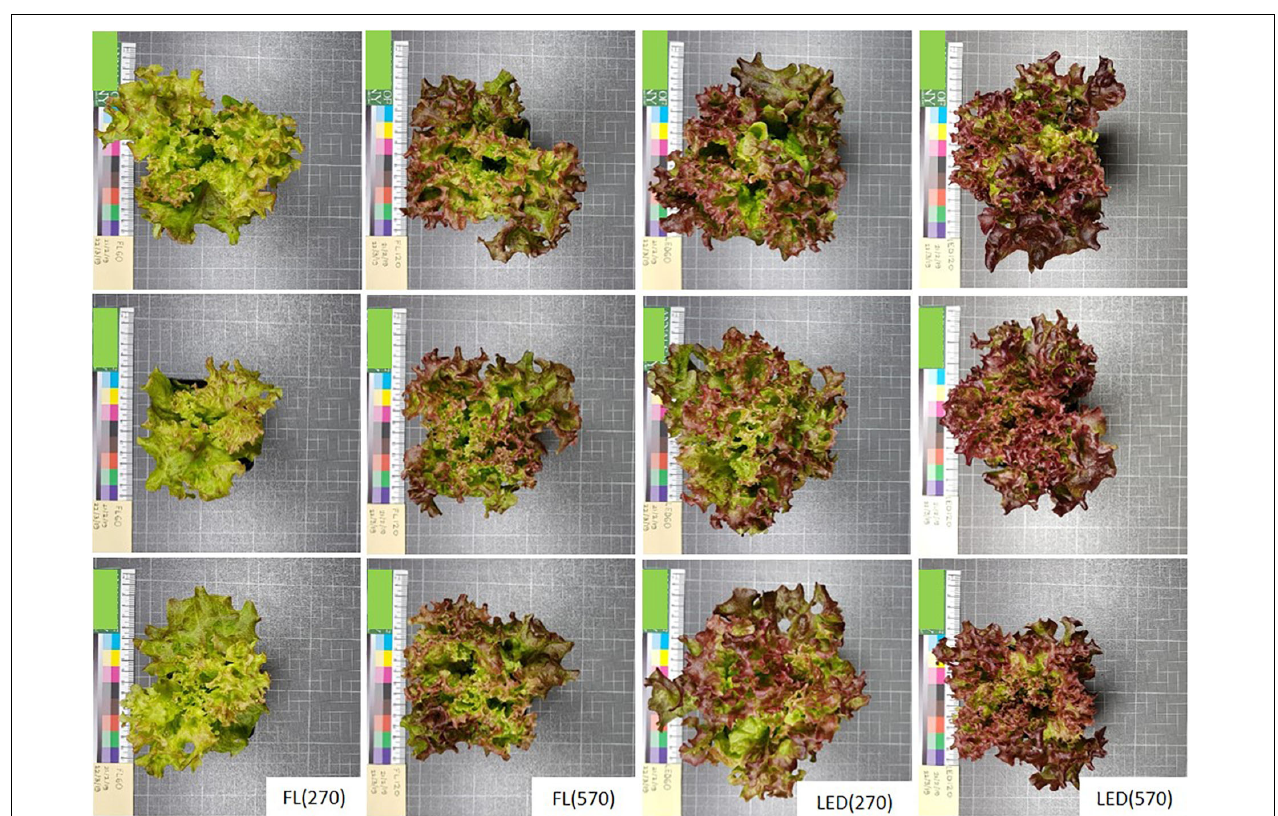
FIGURE 2 | Representative pictures of three of the lettuce replicates treated with different light. Plants grown under fluorescent light (FL) and LEDs at two irradiance levels [270 and 570 µ mol m − 2 s − 1 ) (FL(270), FL(570), LED(270), and LED(570)], showing differences in plant area, crinkliness and pigmentation. Pictures taken 30 days after sowing